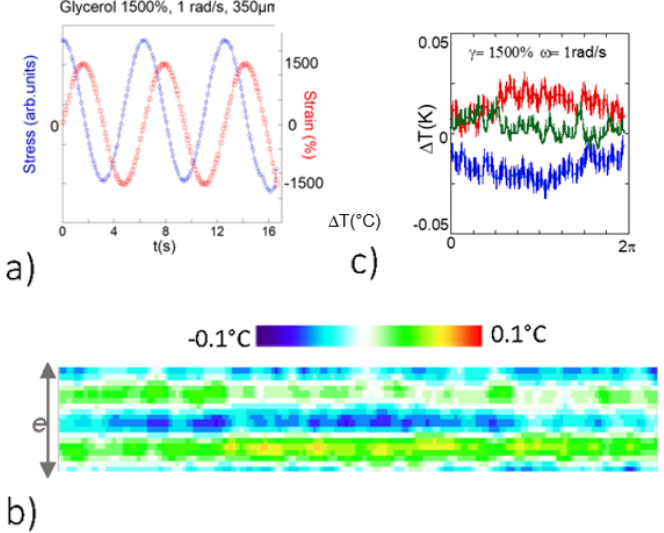
Figure 4. Glycerol: ( a ) Stress–strain curves of glycerol at 350 µm, ω = 1 rad/s, and 1500% (simultane- ous measurement with the thermal measurements; the upper plane was fixed while the bottom one oscillated). ( b ) Thermal mapping of the glycerol along one oscillatory period (at γ = 1500% and e = 350 µm gap thickness, alumina surfaces, room temperature measurements, the upper plane was fixed while the bottom one oscillated at ω = 1 rad/s). ( c ) Temperature profiles over one period of the temperature recorded on the central part (blue points) and on each side of the gap (bottom red) and upper (dark green) bands) at 1500% shear strain and 1